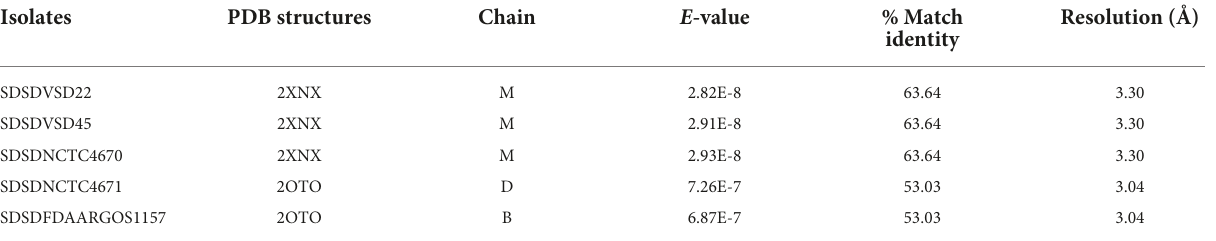
TABLE 2 Protein Data Bank (PDB) identification of the M-like protein sequence from bovine SDSD isolates. Isolates PDB structures Chain